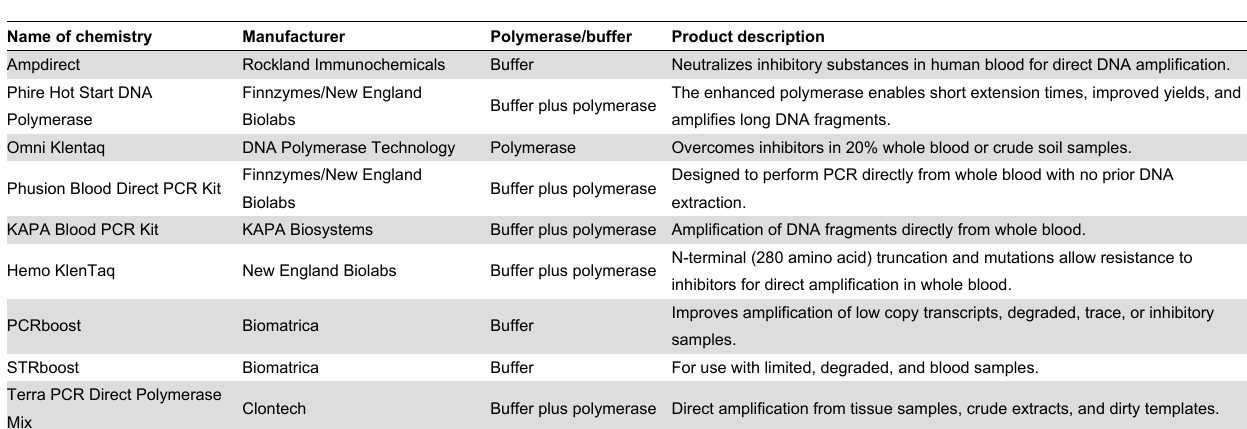
Table 1. Description of each chemistry tested with F. tularensis